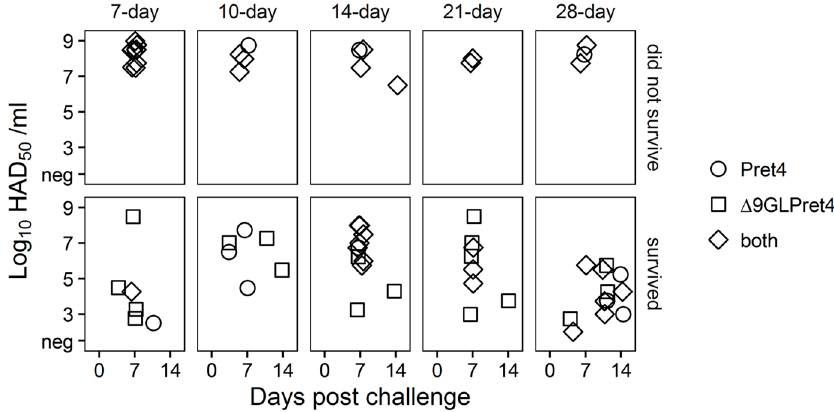
Figure 7. Characterization of circulating virus after the challenge in animals infected with Pret4 Δ 9GL. Identification of the presence of Pret4 Δ 9GL and Pret4 virus was performed by differential PCR based on the detection of β‐ Gus and 9GL genes as markers for Pret4 Δ 9GL and Pret4 virus. The determination was performed using the blood sample with the highest viremia value, after challenge, found in that animal.